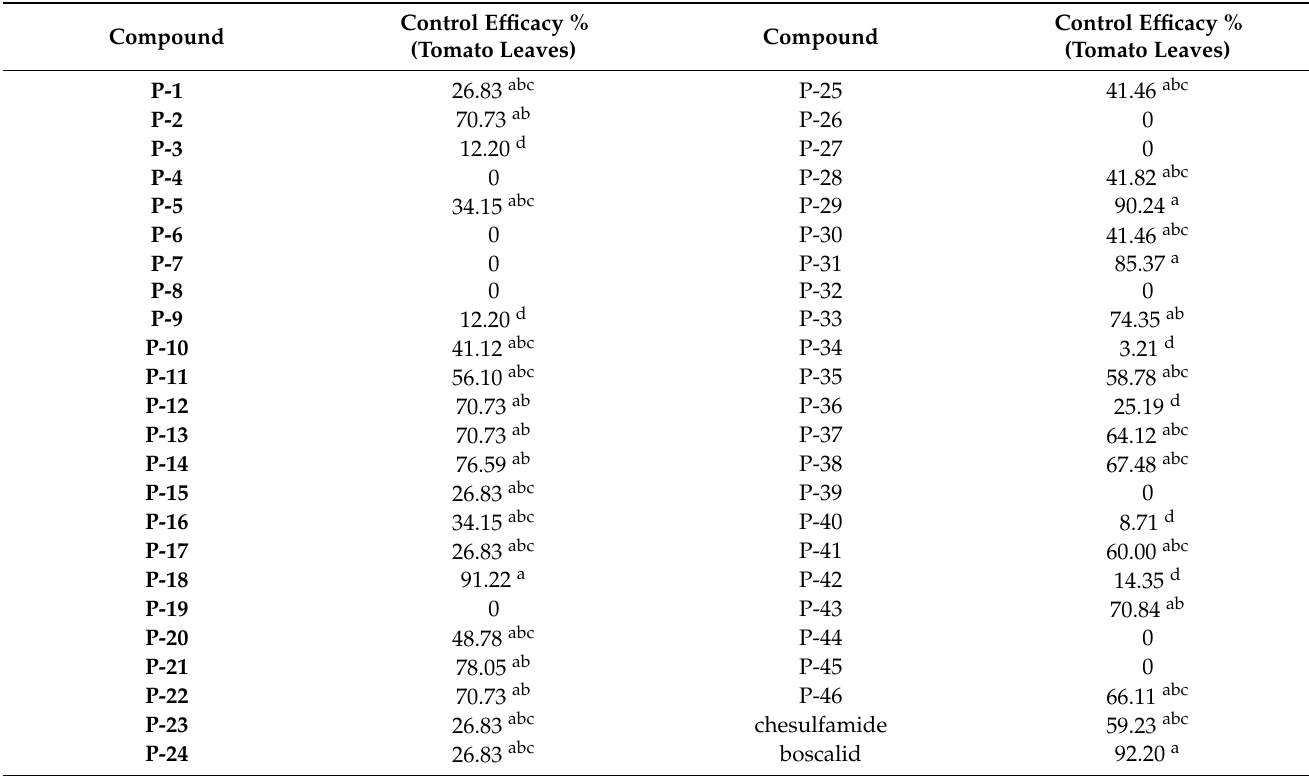
Table 3. Control efficacy of target compounds in tomato pot tests at 200 mg/L.